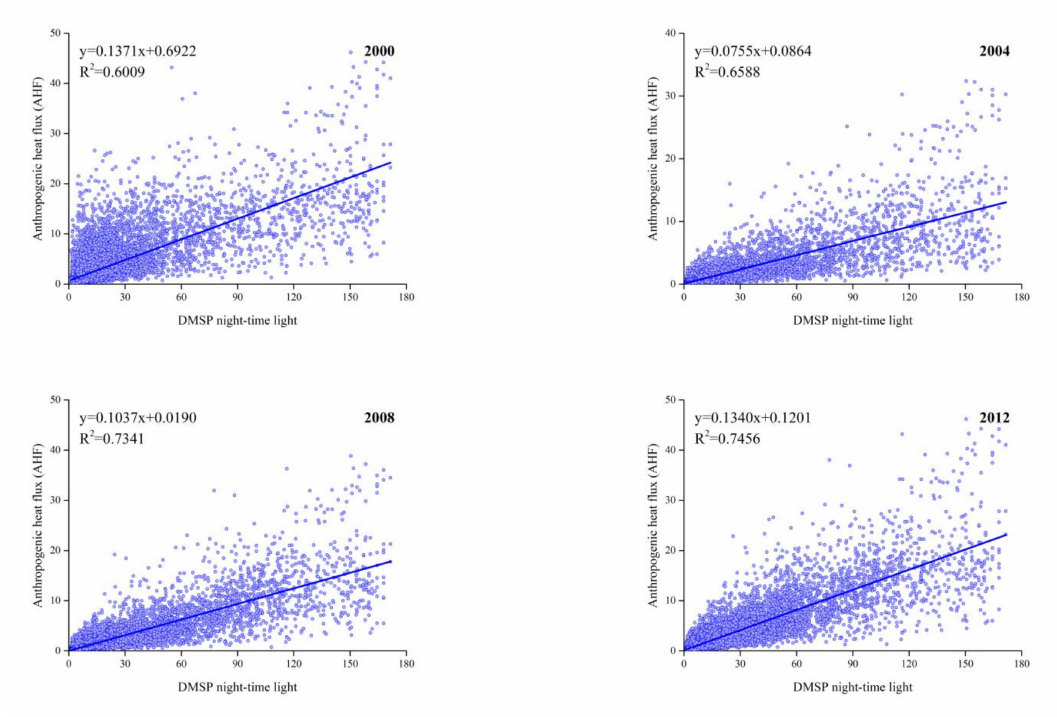
Figure 7. Scatter plot of corrected DMSP nighttime light data and AHF data in 2000, 2004, 2008, and 2012. The blue line represents the relationship obtained by fitting DMSP and